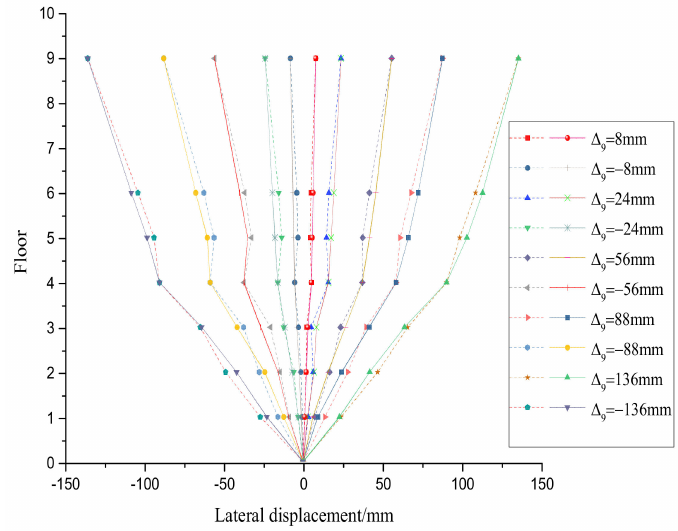
Figure 11. Comparison of lateral displacement.